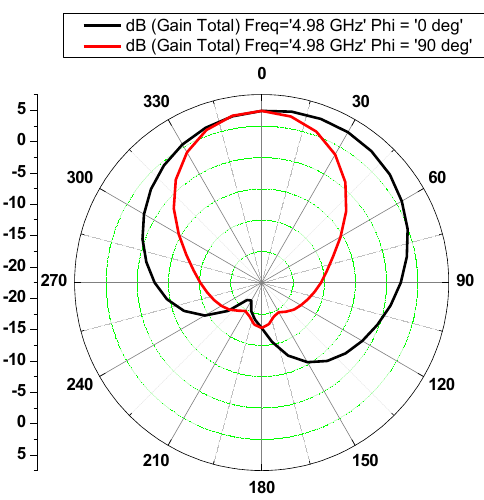
Figure 10:Radiation pattern of 1×2 MTPAA at 4.98 GHz